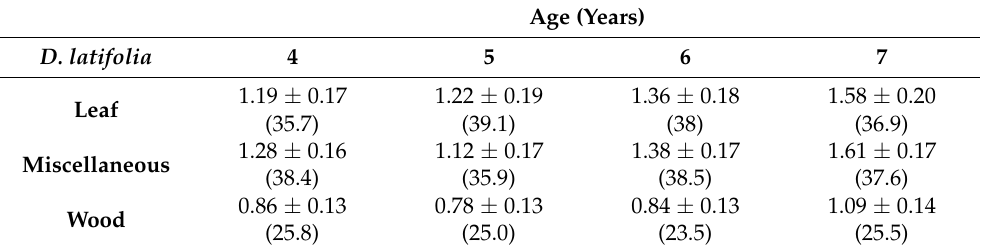
Table 6. Component-wise total litterfall (Mg ha − 1 ) mean ± SE of D. latifolia plantation of different ages: